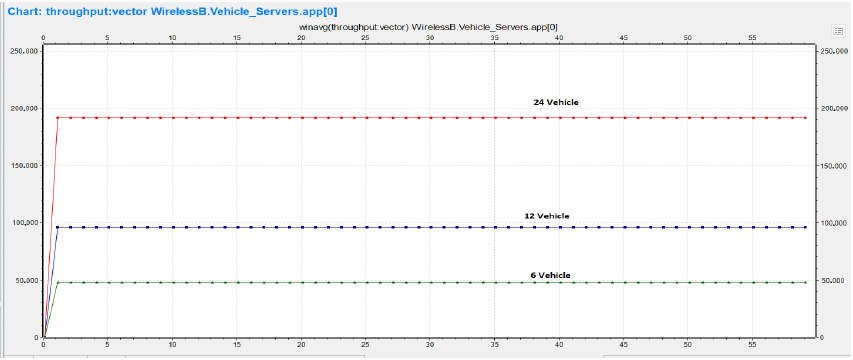
Figure 19. System’s throughputs for 6, 12, and 24 vehicles.